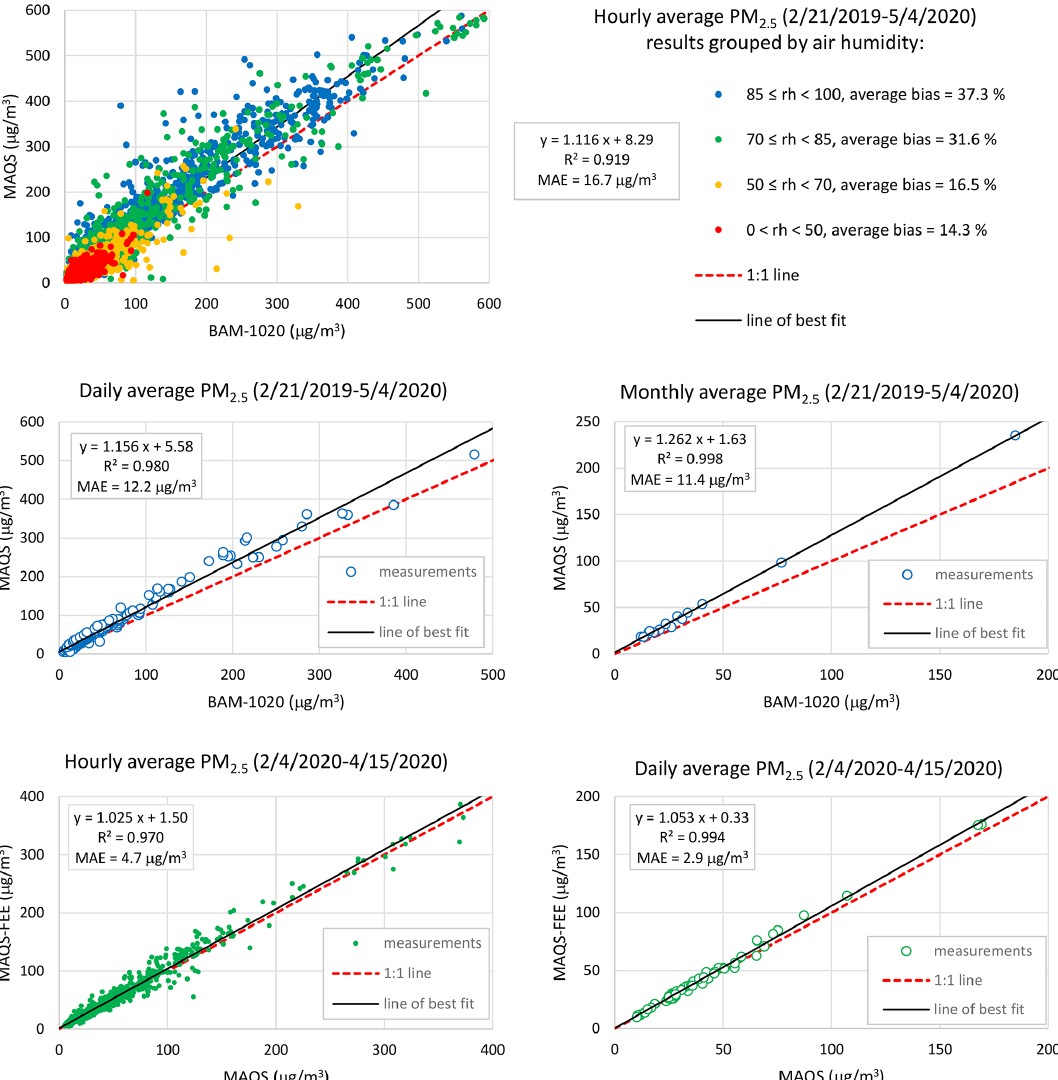
Figure 8. Long-term comparisons of the MAQS sensor with BAM operated by the US EPA at the nearby location: hourly, daily, and monthly average values and comparison of hourly and daily average values of two MAQS sensors: the first one (MAQS) at our main facility and the second one (MAQS-FEE) at the Faculty of Electrical Engineering in the immediate vicinity of BAM-1020.